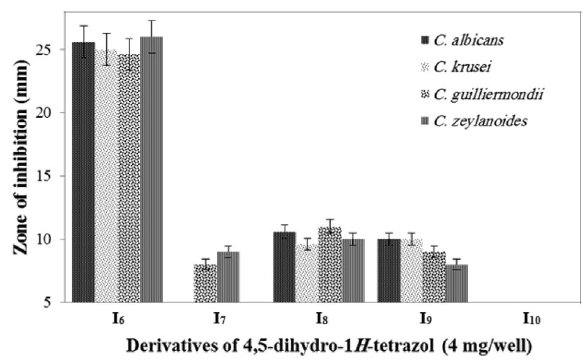
Figure 3. Zone of inhibition of Candida sp. using the prepared tetrazole